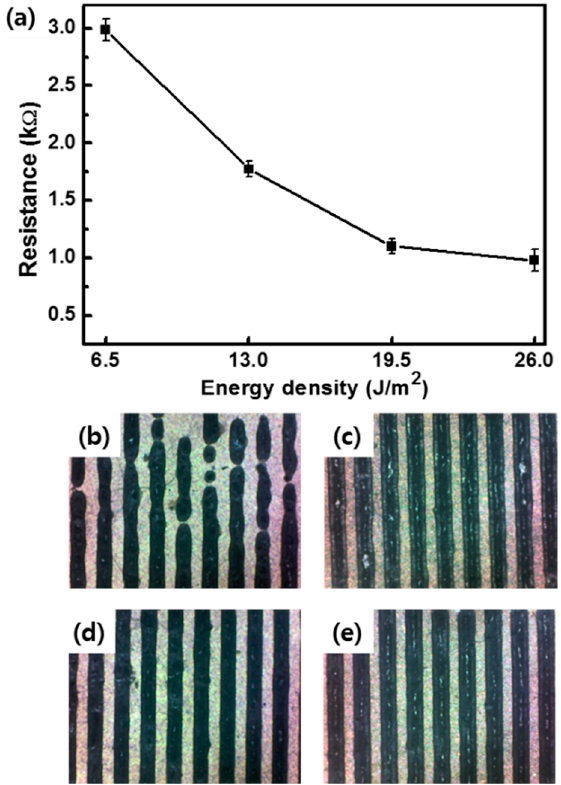
Figure 5. The patterned rGO-GO sheet resistance and optical image according to pulsed energy 6.5 J/cm 2 at one time. Sheet resistance ( a ), optical images of 6.5 J/m 2 ( b ), 13 J/m 2 ( c ), 19.5 J/m 2 ( d ), and 26 J/m 2 ( e ).